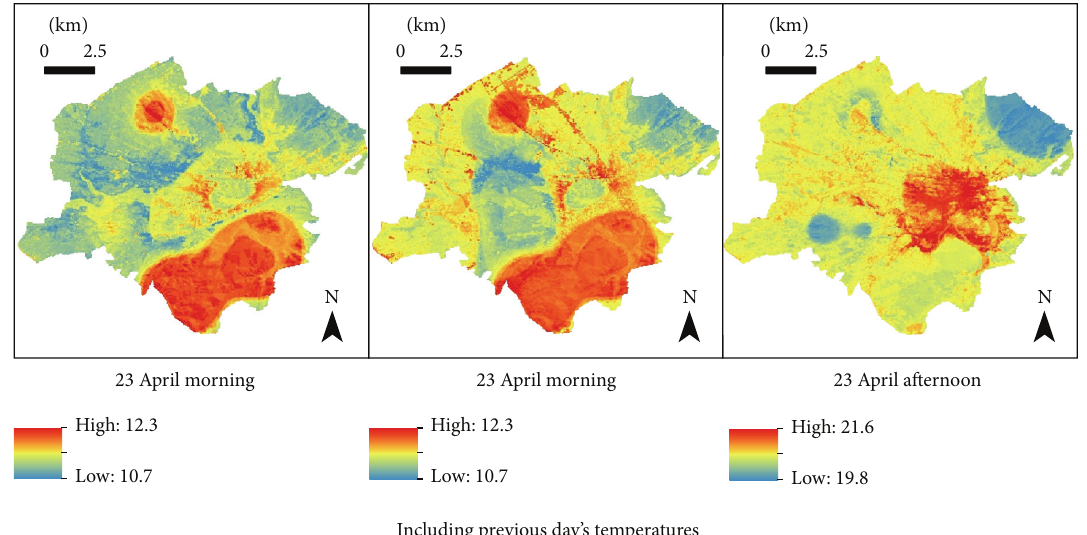
Figure 13: Estimated temperatures ( ∘ C) for 23 April 2013. Left image does not include lag-1 variable, middle image includes lag-1 variable, and image on right depicts